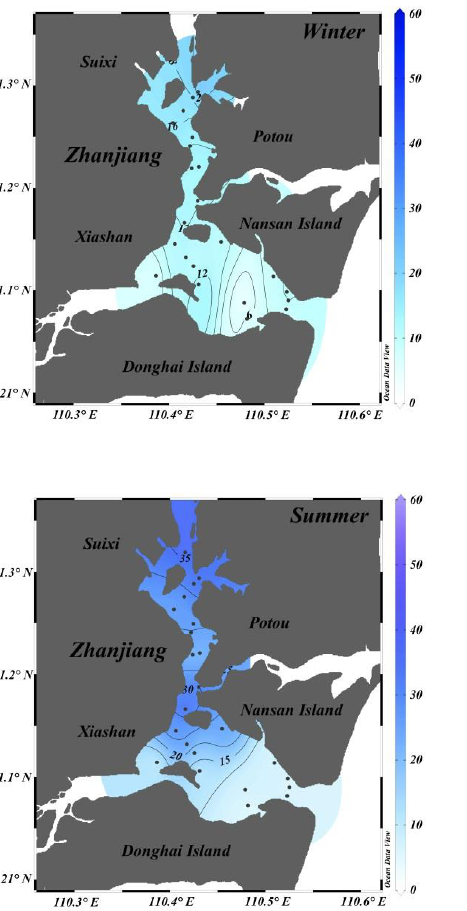
Figure 2. Spatiotemporal dissolved silicate (DSi) distribution in the Zhanjiang Bay coastal water.